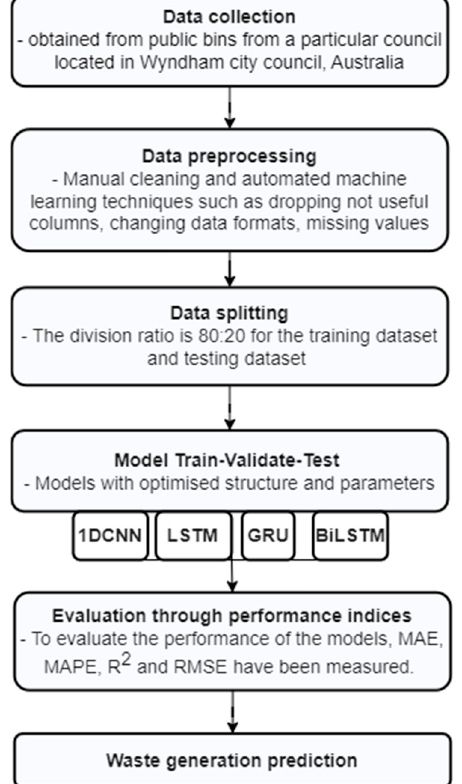
Figure 1. Methodology to deal with the data processing and selecting models.